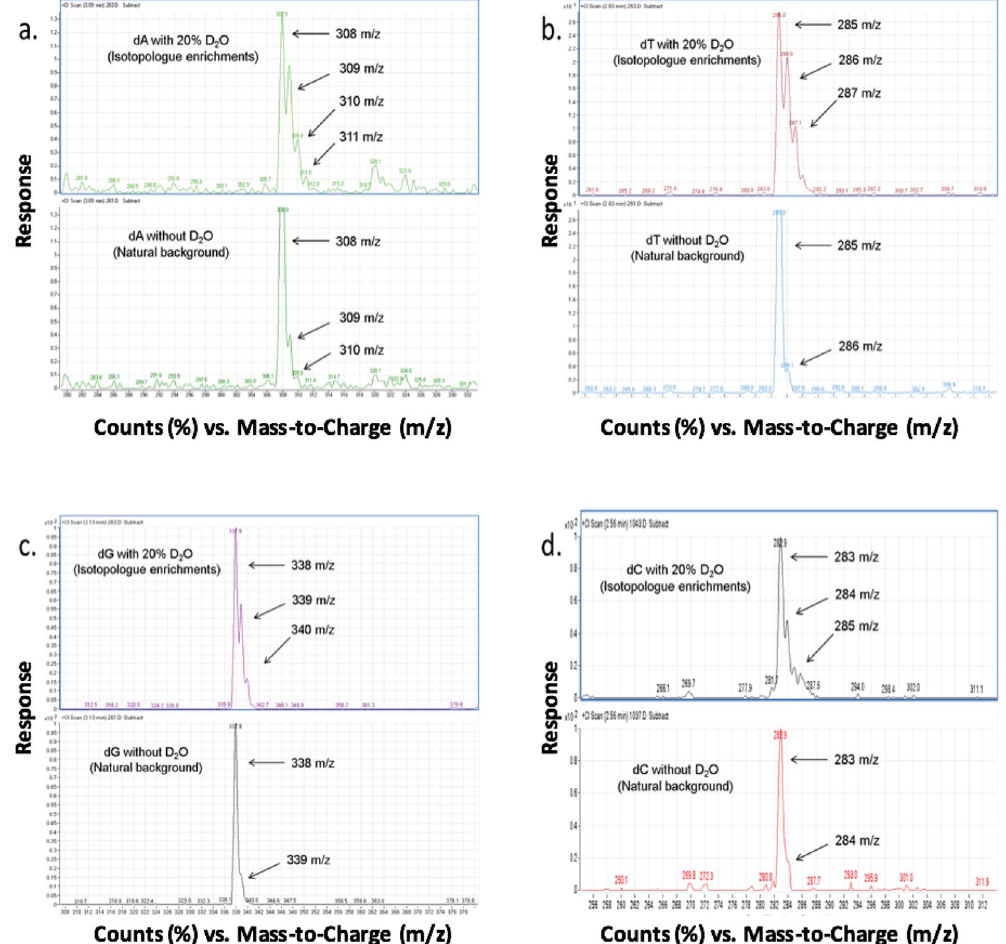
Figure 3. Mass spectrometry isotopic signatures for D 2 O enrichments into the mouse thymus tumor cell DNA nucleosides after 3–5 days of incubation. The mouse thymus tumor cells were incubated in cell media (with and without 20% D 2 O, (v/v)). The natural isotopic background and the deuterium enrichments into the isotopologues (e.g. M + 1, M + 2) are shown for methylated derivatives of ( a ) deoxyadenosine (dA), MW 308 Da, ( b ) deoxythymidine (dT), MW 285 Da, ( c ) deoxyguanosine (dG), MW 338 Da, and ( d ) deoxycytidine (dC), MW 283